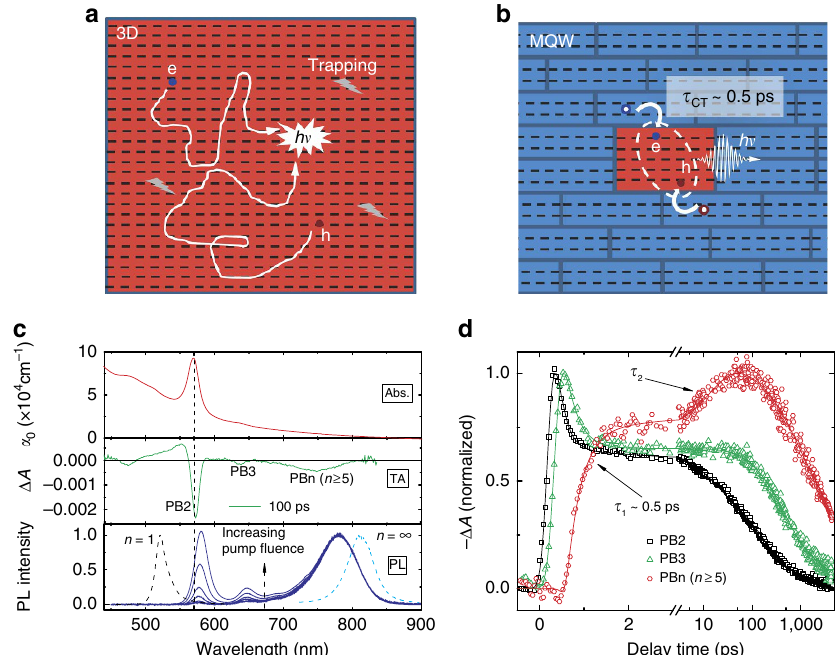
Figure 1 | Van-der-Waals coupled perovskite multi-quantum wells (MQWs) for light emission. ( a ) An illustration of the fundamental limitation in three- dimensional (3D) perovskite electroluminescence—defect states trapping although rare, can still be very effective in competing with the slow bimolecular recombination at low carrier excitation densities. ( b ) Illustration of charge injection, exciton localization ( t CT ) and subsequent recombination in the perovskite MQWs from the thin QWs ( n r 4, host) to the self-assembled thick ( n Z 5) QW (TQW) dopants. ( c ) Ultraviolet-Vis absorbance (Abs.), chirp- corrected photo-induced changes in absorption ( D A ) and pump fluence dependent photoluminescence (PL) spectra (blue lines, normalized at 780nm) for perovskite MQWs film. The TA was performed with 400nm excitation (at 1KHz, 100fs, around 0.4 m Jcm (cid:2) 2 ). The PL spectra were collected by varying pump fluence of the same laser beam from 0.002 to 7.3 m Jcm (cid:2) 2 . The PL spectra of 2D ( n ¼ 1) and 3D ( n ¼ N ) perovskite films (at 7.3 m Jcm (cid:2) 2 ) are also shown here for comparison. ( d ) Normalized bleaching kinetics at PB2 (2.18eV), PB3 (1.96eV) and PBn (1.65eV) as indicated in c